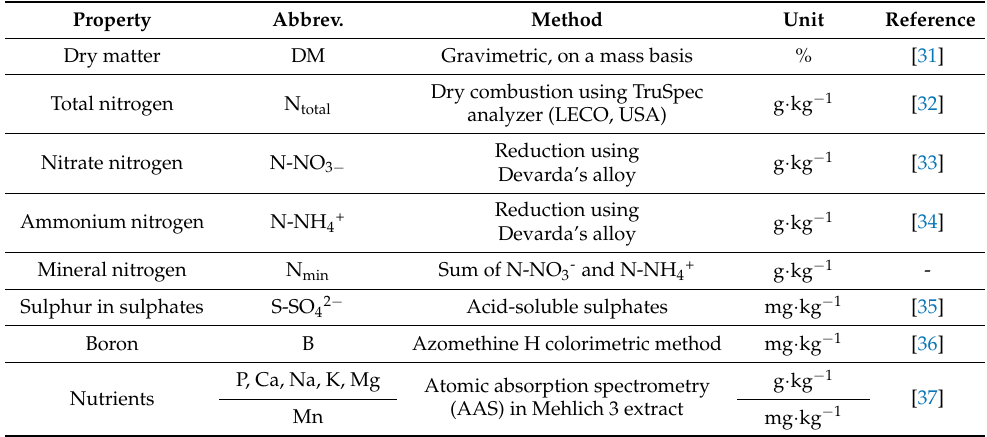
Table 2. Determined digestate properties, methods used for measurement, relevant